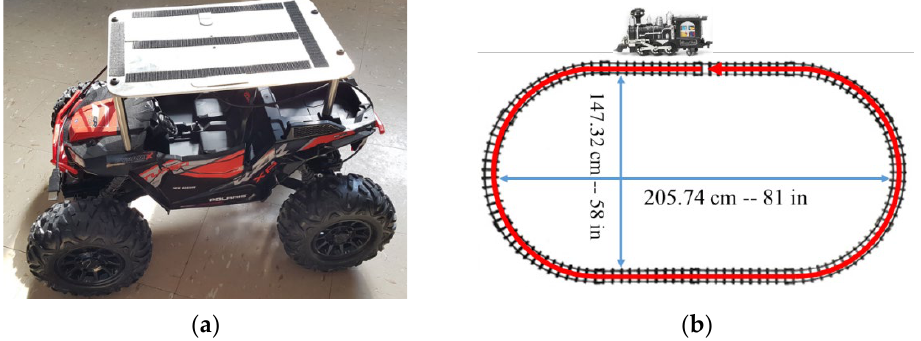
Figure 6. Experimental setups. ( a ) Application of the remote-control car. ( b ) Application of the toy train and track.